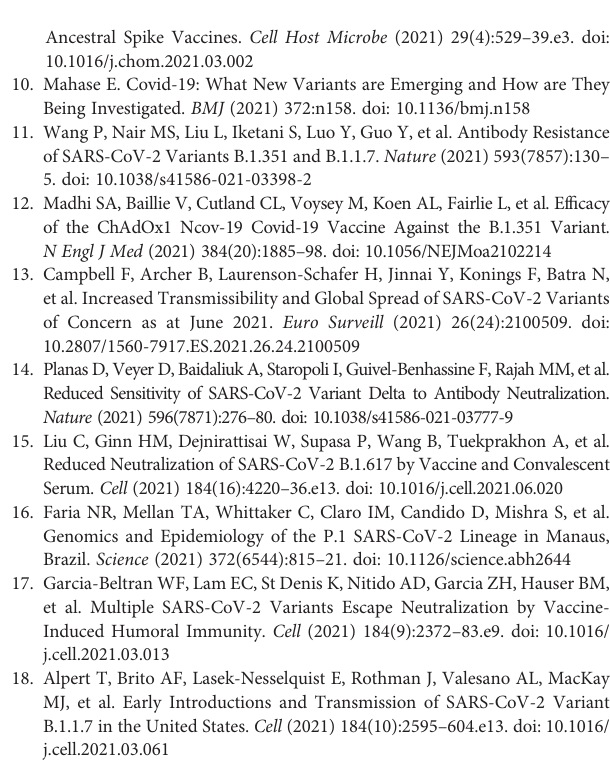
Supplementary Figure 1 | Brief information of six former VOI variants. Six former VOC variants (B.1.427/429, P.2,P.3, B.1.525, B.1.526, and B.1.617.1) are marked in the arrow according to the date of designation, and their related brief information (e.g., the time and location of earliest documented samples, infectivity, main mutations, immune escape ability) are displayed in the corresponding location. Supplementary Figure 2 | Mutations of six former VOI variants. Schematic showing the locations of amino acid substitutions of six former VOI